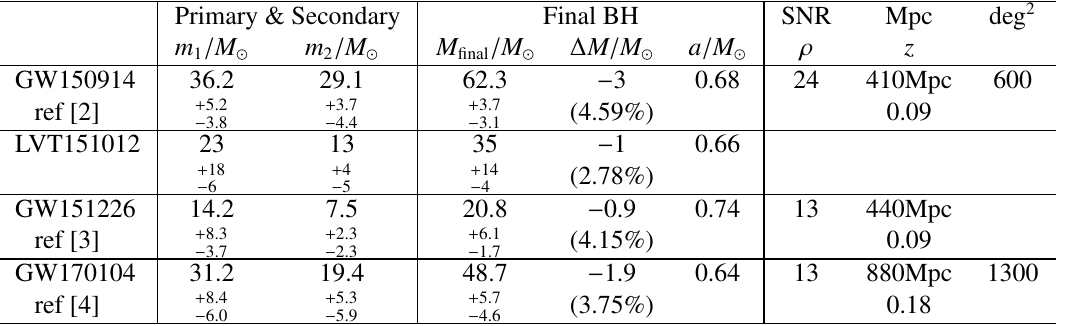
Table 1. GW events (as of July